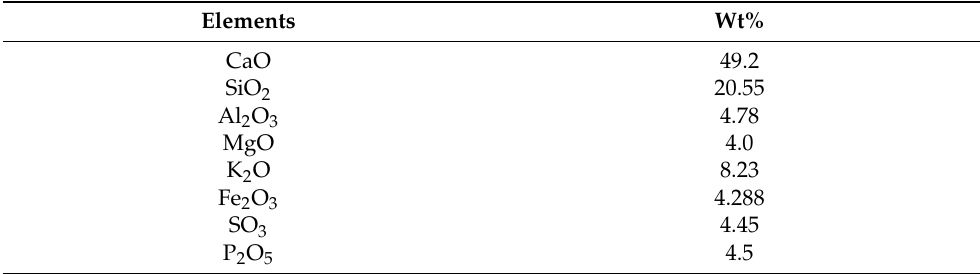
Table 1. Elemental composition of incense stick ash as found by XRF.